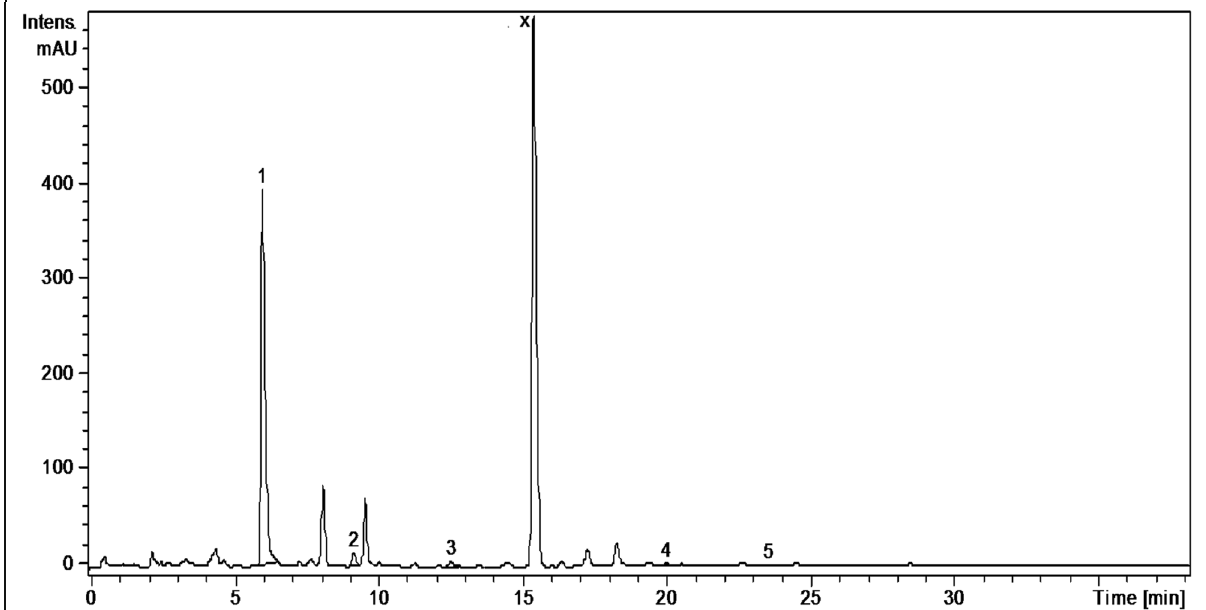
Fig. 3 HPLC chromatograms of G. nivalis extract. Notes : The identified compounds: 1-chlorogenic acid; 2- p -coumaric acid; 3-ferulic acid; 4-isoquercitrin;